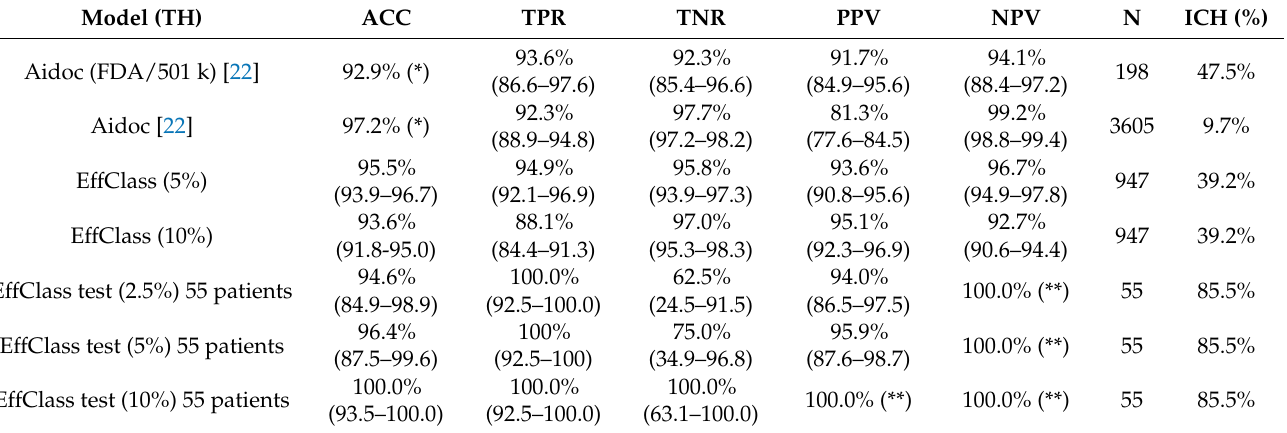
Table 2. Results per model, with at least n % of the slices with ICH. The best metric per model and threshold ( TH ) are marked in bold. EffClass : EfficientClassification, ACC: Accuracy, TPR: Sensitivity (Recall), TNR: Specificity, PPV: Positive Predictive Value (Precision), NPV: Negative Predictive Value, N: Number of patients, ICH (%): Percentage of patients with ICH. (*): No confidence interval provided. (**) Confidence interval impossible to